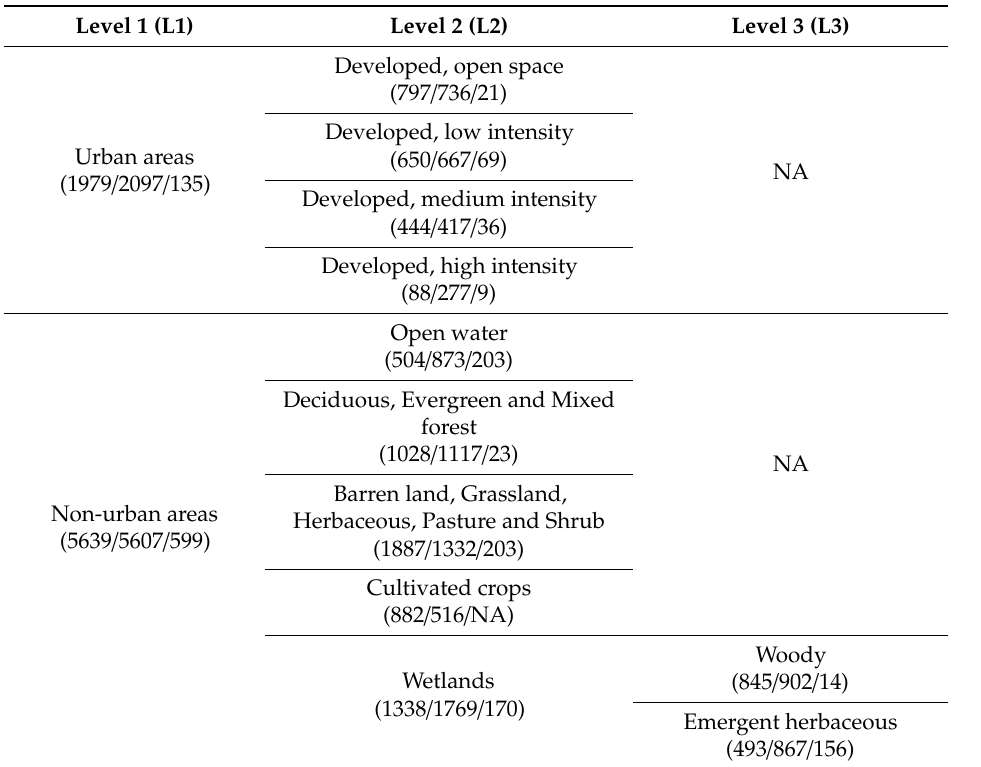
Table 3. Nomenclature levels and number of polygon features (Weeks Bay / Savannah / Fire Island) used to validate the random forest classifiers for land cover